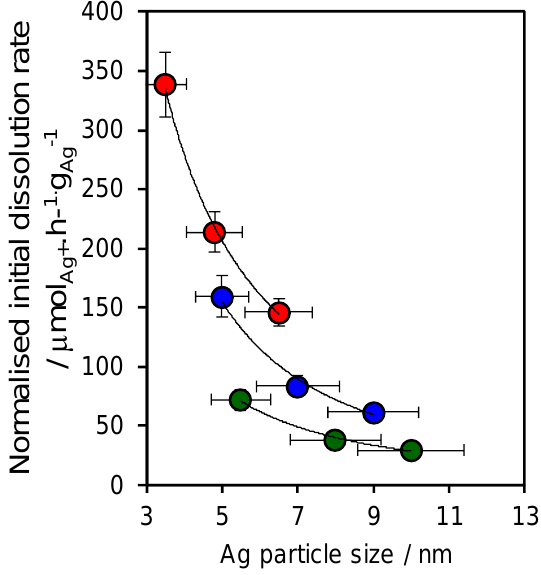
Figure 5. Ag + dissolution rates normalized to mass of Ag determined by XANES for Ag/SBA-15, Ag/TiO 2 /SBA-15 and Ag/TiO 2 /MM-SBA-15.